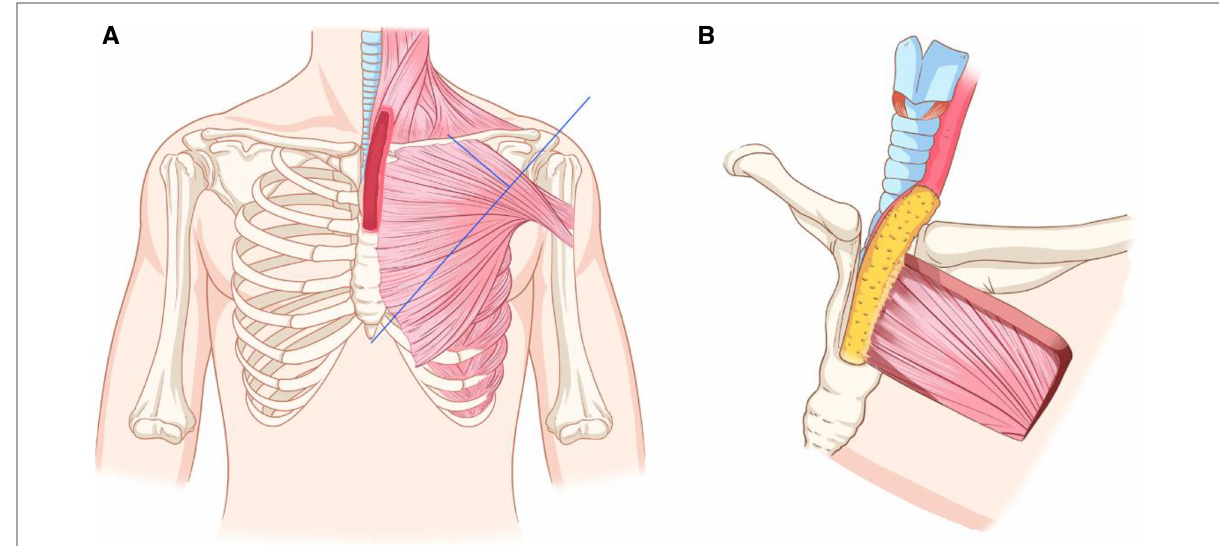
FIGURE 2 The preoperative Schematic diagram of designing of pedicled TAAP fl ap and the reconstruction process for this case. ( A ) Designing of a PTTA fl ap. ( B ) The fl ap was sutured to the residual